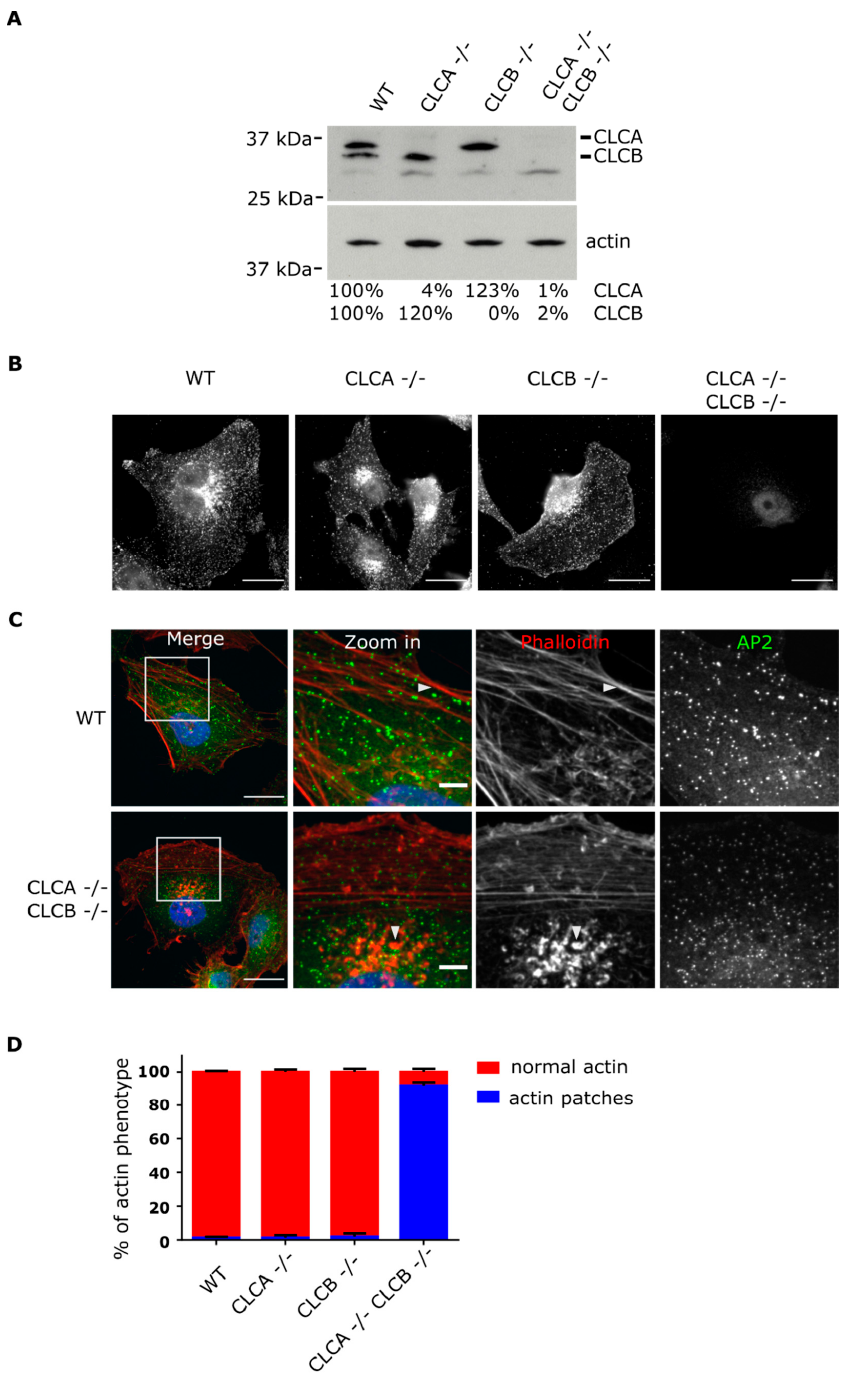
Figure 1. Knockout of CLCA and CLCB induces formation of actin patches at the ventral plasma membrane. ( A ) Western blot analysis of WT, CLCA − / − , CLCB − / − and CLCA − / − CLCB − / − cell lines using an antibody against CLC and actin. ( B ) Representative epifluorescence images of genome edited U373 cells. CLCs were immunostained using an anti-CLC antibody, scale bar indicates 20 µ m. ( C ) Representative confocal images of WT, CLCA − / − , CLCB − / − and CLCA − / − CLCB − / − U373 cells stably expressing the clathrin adaptor AP2 fused to GFP (green). Actin was stained with phalloidin Alexa Fluor 647 (red). Zoom in of actin structures, scale bar indicates 20 µ m for merge and 5 µ m zoom in. White arrows indicate representative actin structures. ( D ) Quantification of relative percentage of actin phenotype among U373 WT, CLCA − / − , CLCB − / − and CLCA − / − CLCB − / − cell lines. Cells displaying actin patches were quantified, displayed as the mean and SD, n = 3, 300 cells per